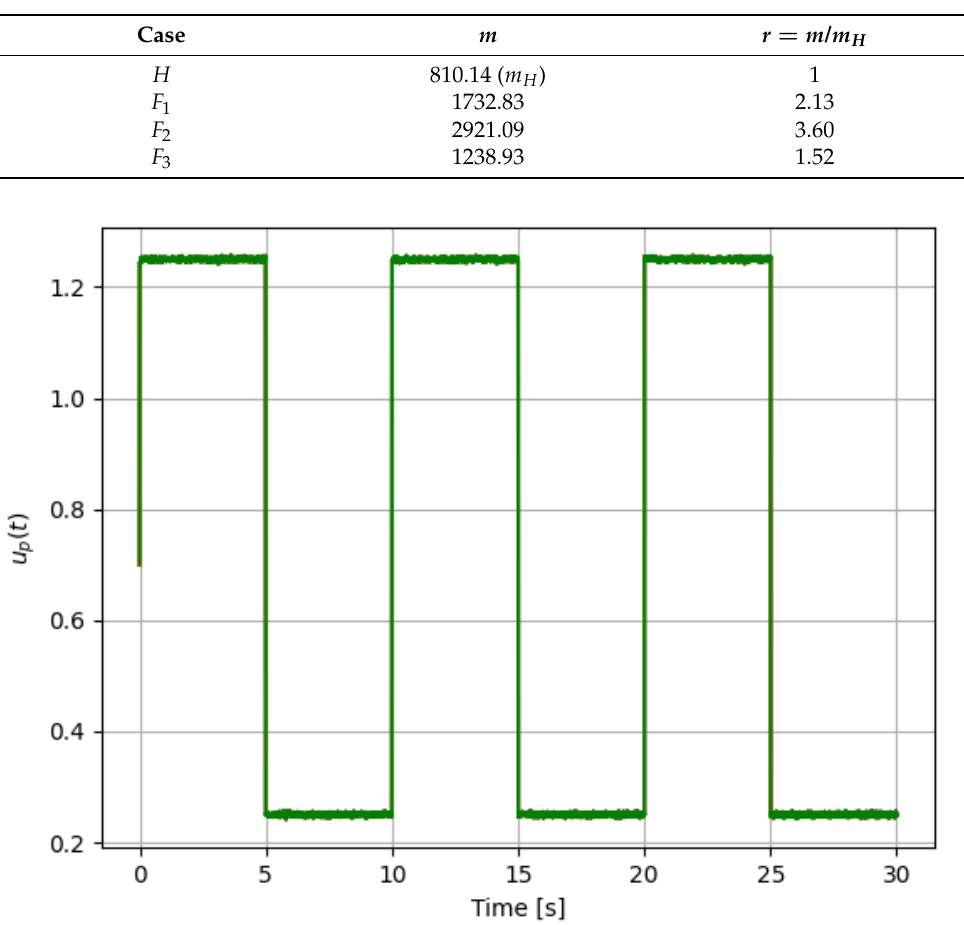
Table 4. First numerical experiment results of regression parameter m .